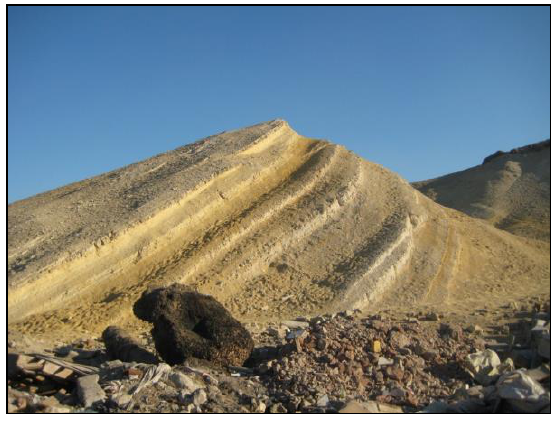
Figure 2: Accessible road in the entrance to the of Abu-Roash area, open fold with different facies appear also